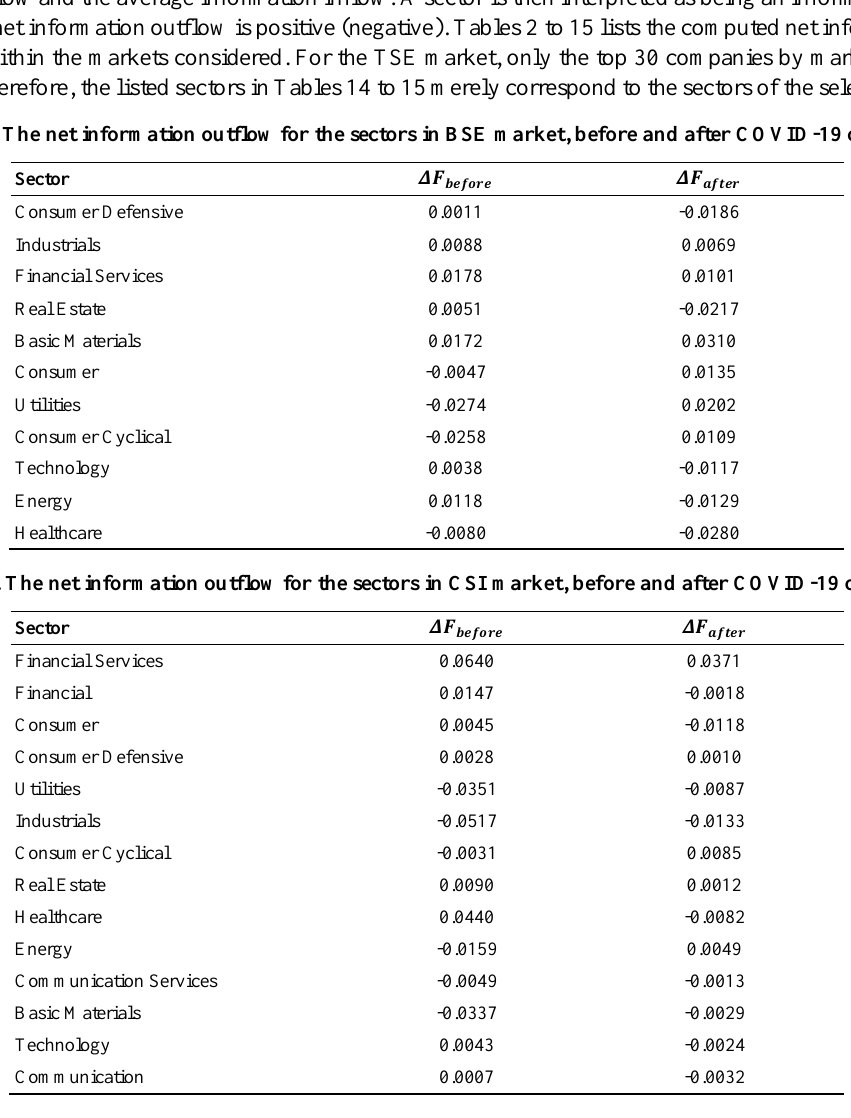
Table 4. The net information outflow for the sectors in FSE market, before and after COVID-19